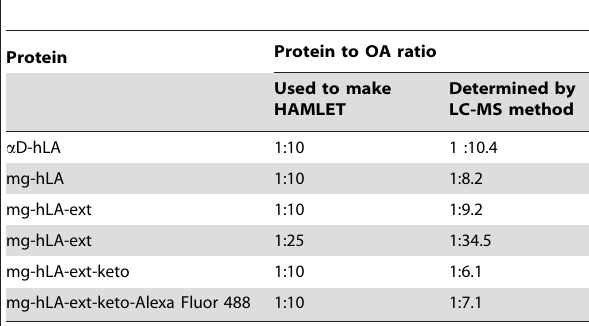
Table 1. Oleic acid content determined from the HAMLET preparations using LC-MS method.